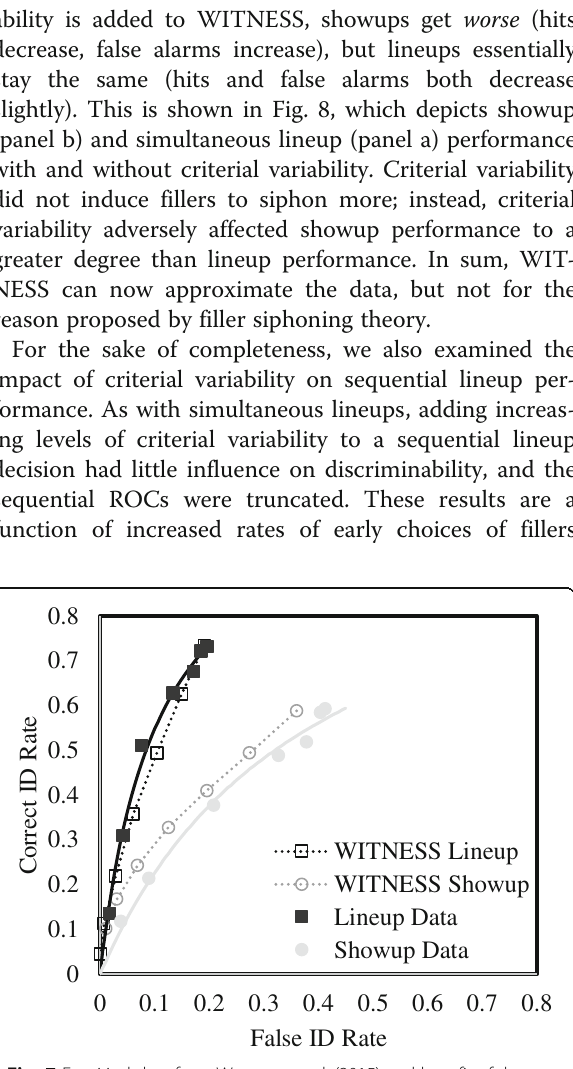
Fig. 7 Empirical data from Wetmore et al. (2015) and best fit of the WITNESS model with criterial variability. Best fitting parameters were: a =. 38 , SSF =.45, SSP =.55, csim ~ N ( μ = .07, = .80 * μ ), csu ~ N ( μ = .105, = .80 * μ ). SSP Similarity of the innocent Suspect to the PERP, SSF